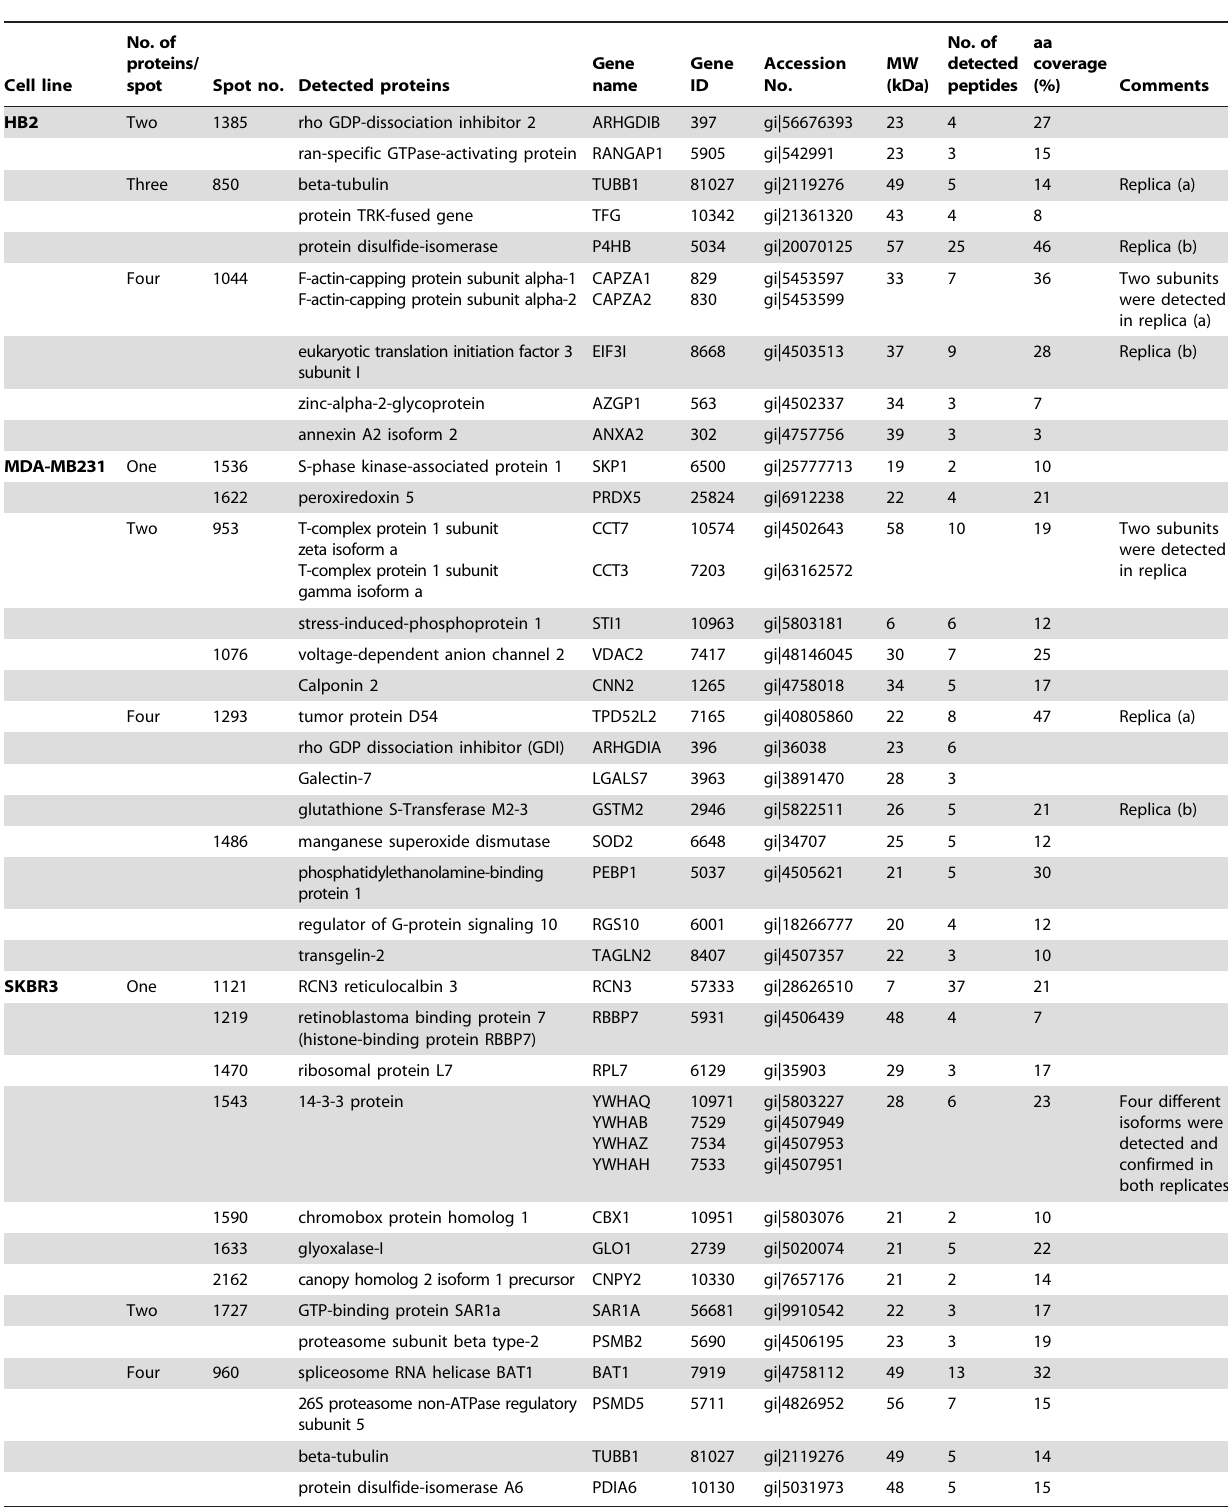
Table 3. Detected proteins using capillary liquid chromatography tandem MS within three analyzed cell lines.